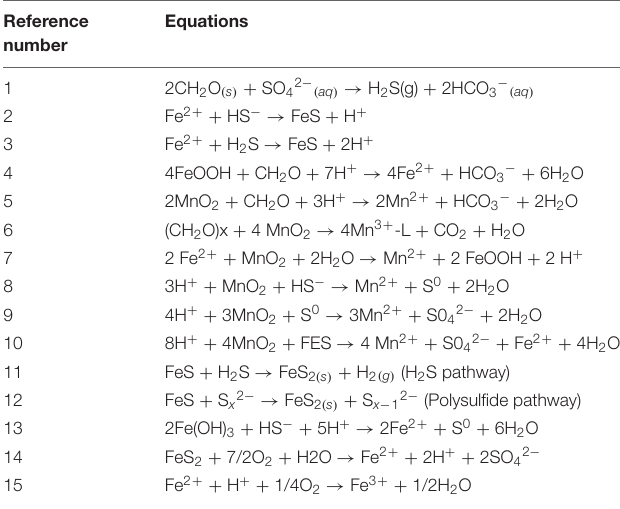
TABLE 4 | Main reactions identified in diagenetic processes in shrimp